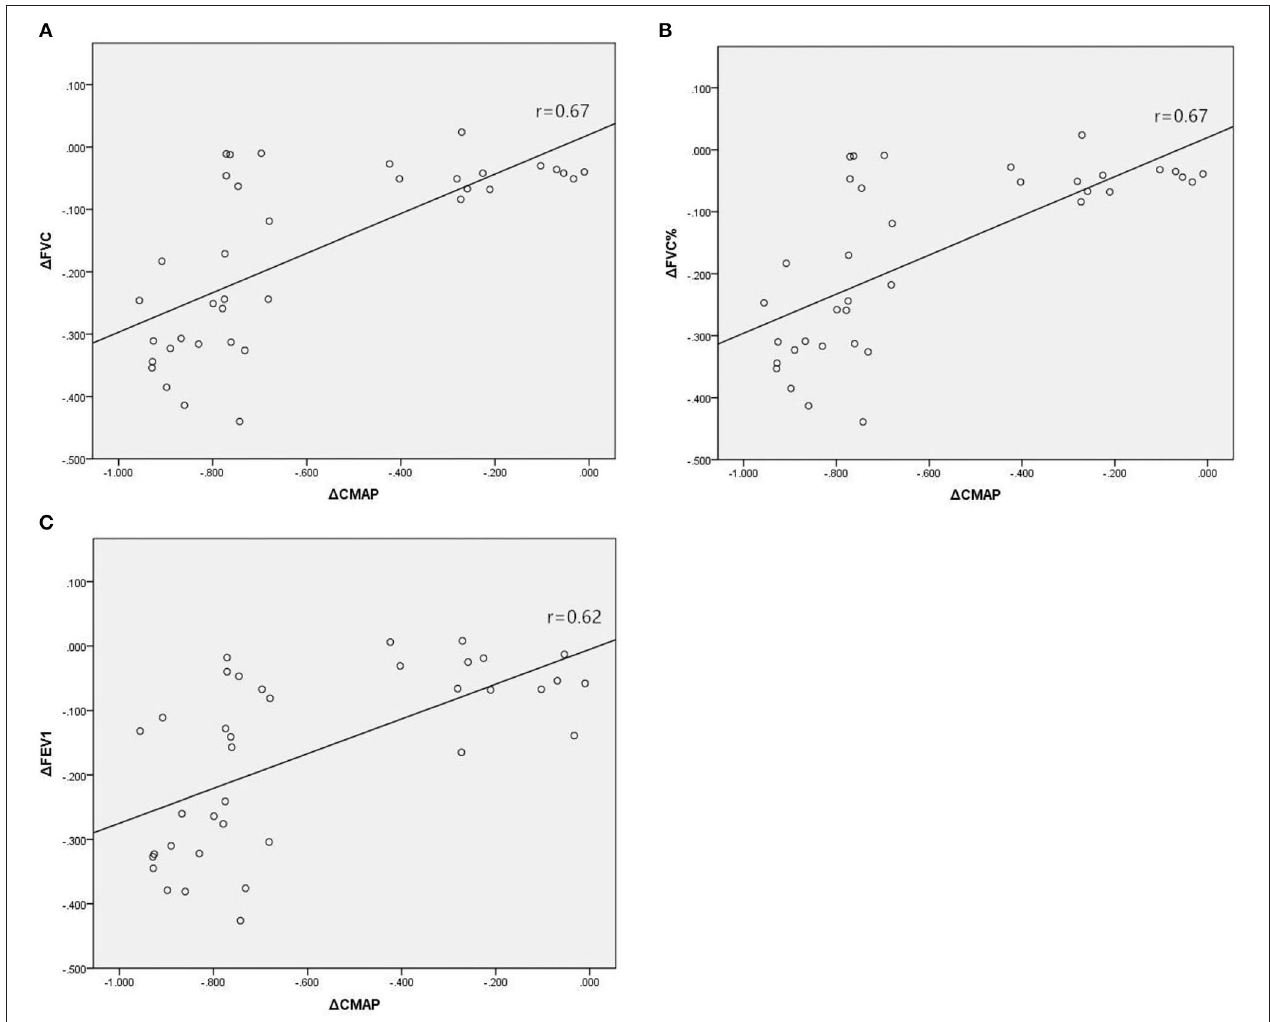
FIGURE 3 | Associations between relative changes ( 1 ) in diaphragm CMAP amplitude and FVC (A) , FVC% (B) , and FEV1 (C) before and 30min after SCBPB in Group B. CMAP, compound muscle action potential; FVC, forced vital capacity; FVC%, predicted value of FVC; FEV1, forced expiratory flow in the first